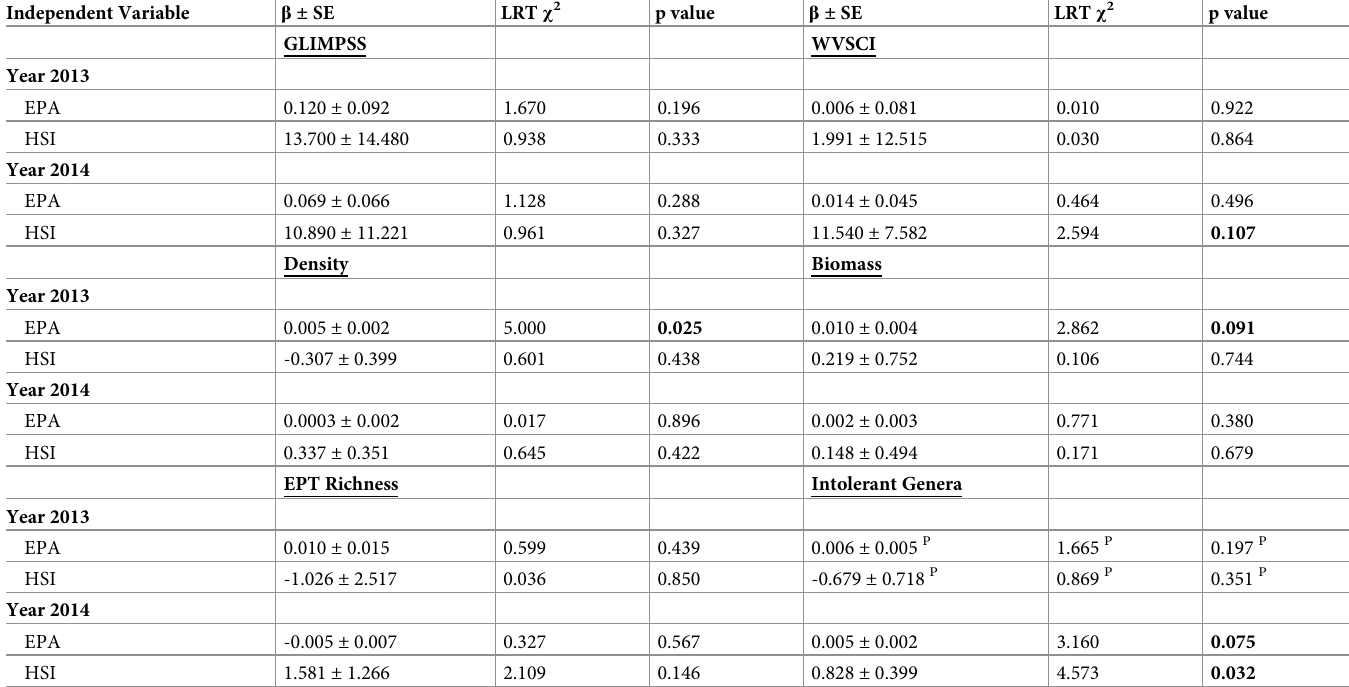
Table 2. Association between waterthrush riparian habitat quality indices (i.e., EPA and HSI) and aquatic prey metrics in spatial generalized linear mixed models. In 2013, aquatic prey biomass and density increased with increasing EPA score, while in 2014 intolerant genera increased with increasing EPA score. No relationships were statistically significant in 2013 between HSI and aquatic prey, but in 2014 intolerant genera and WVSCI (approaching significance) increased with increasing HSI score. Results with P are from a Poisson model. P values of variables that are statistically significant are bolded. Variable names are defined in S2 Table. LRT = likelihood ratio test χ 2 statistic. β = beta estimate of fixed